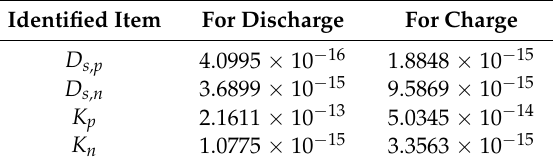
Table 4. Identified items for 24 h OD battery.